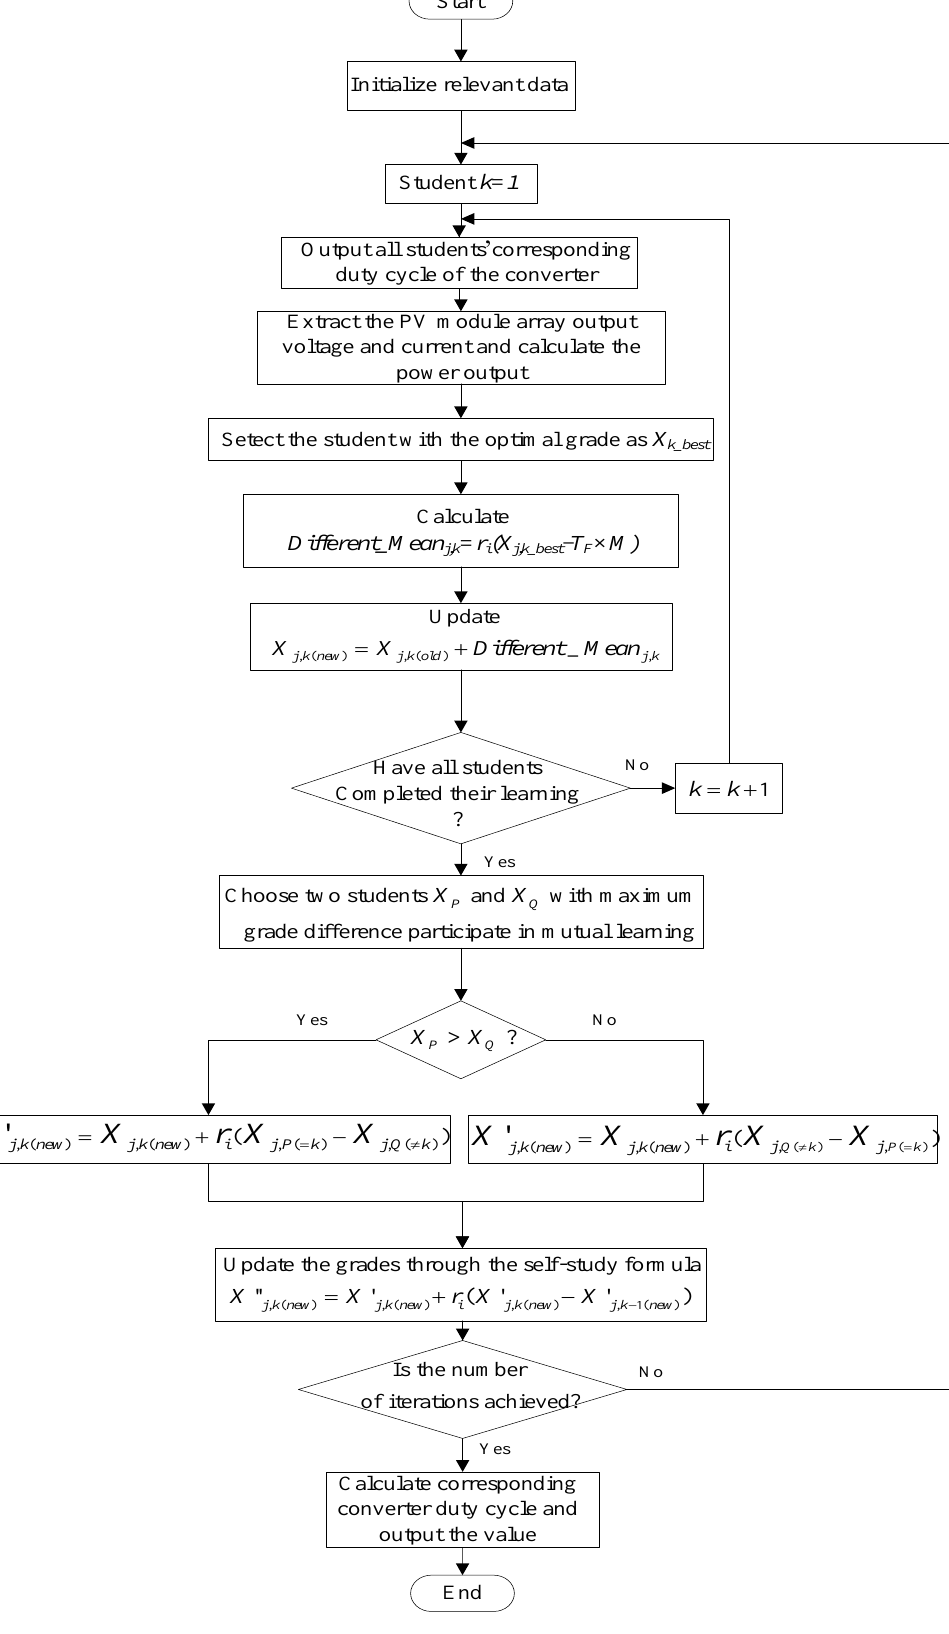
Figure 5. MPPT flow chart of the proposed I-TLBO.